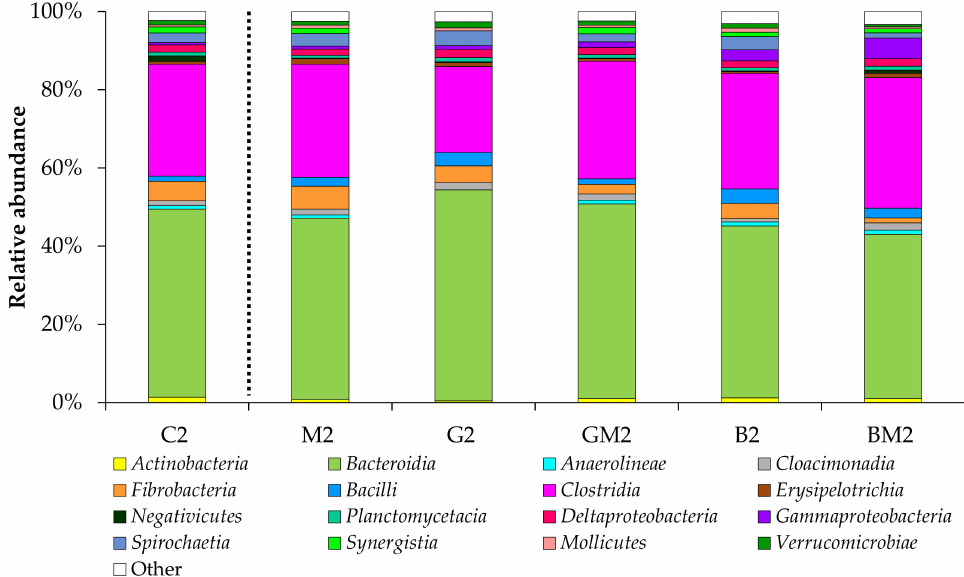
Figure 5. Taxonomic composition of bacterial communities in the anaerobic reactors (sampled on day 6; class level). Classes with abundances below 1% are summarized as